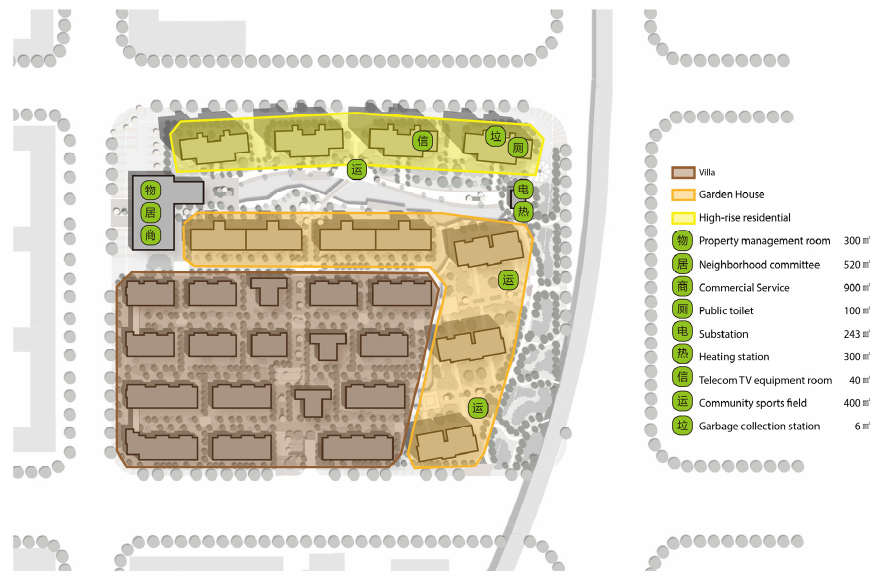
Figure 11. The two-dimensional planning of Tianjin Tianbao Gold Coast